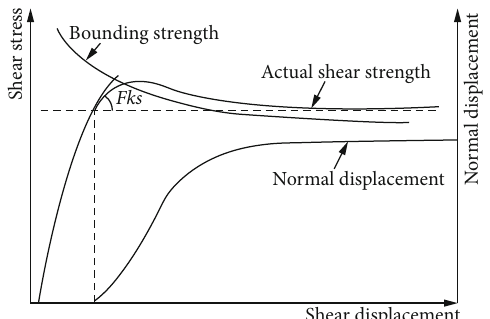
Figure 1: A typical shear stress-displacement curve, normal displacement curve [30], and bounding shear strength curve